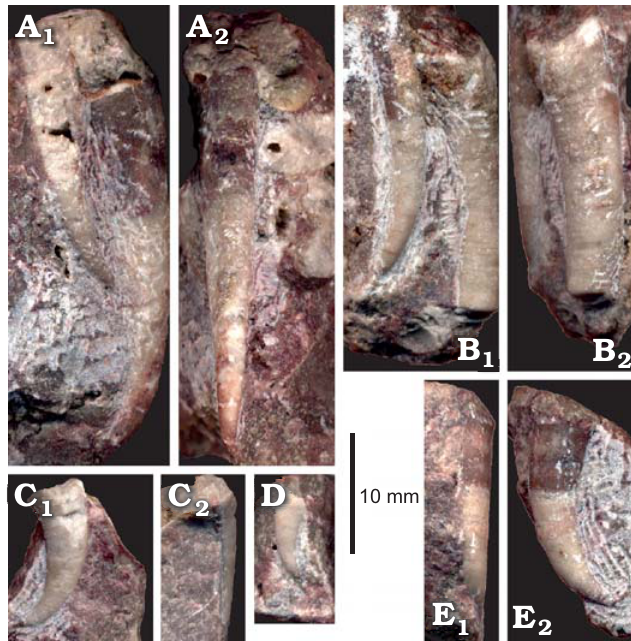
Fig. 9. Apical parts of ellesmeroceratid nautiloid conchs (interpreted below as Ruthenoceras elongatum Korde, 1949) from sample Ang-4, block No. 1, probably latest Furongian Ust-kut For mation found at Pashino on the Angara River, Siberia, Russia. A , B . ZPAL N. IV/11 and 117, respectively; conchs with low expansion rate rate in lateral (A 1 , B 1 ) and dorsal (A 2 , B 2 ) views. C – E . ZPAL N. IV/103, 18, and 114, respectively; conchs with high expan- sion rate rate in lateral (C 1 , D, E 2 ), ventral (C 2 ), and dorsal (E 1 ) views.